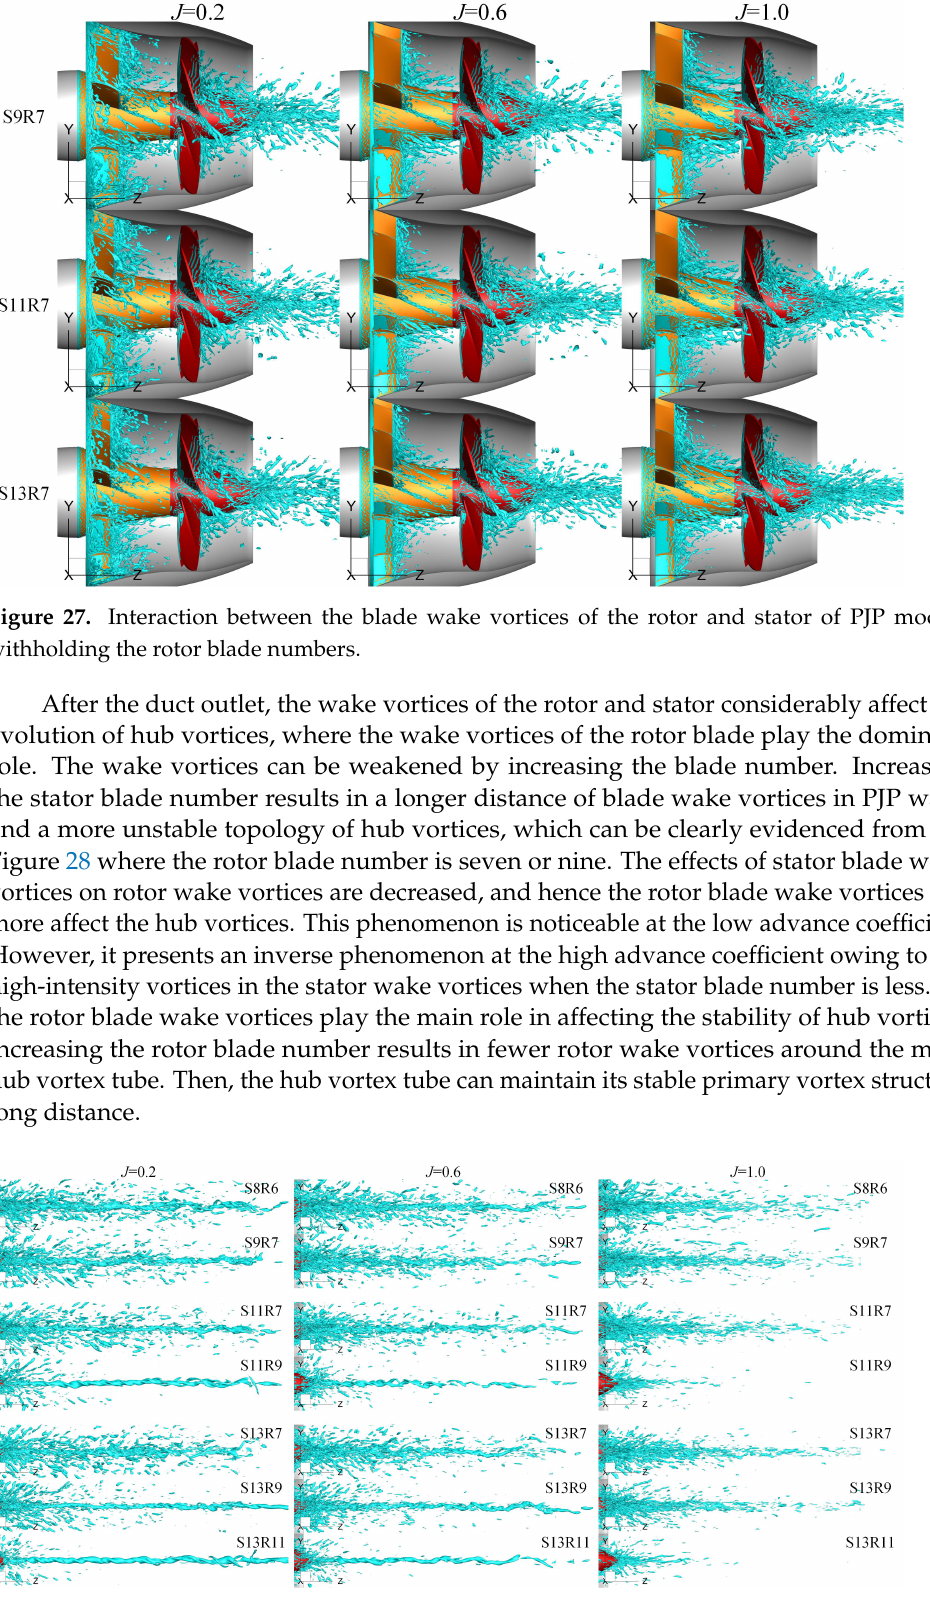
Figure 28. Hub wake vortices under different rotor and stator blade